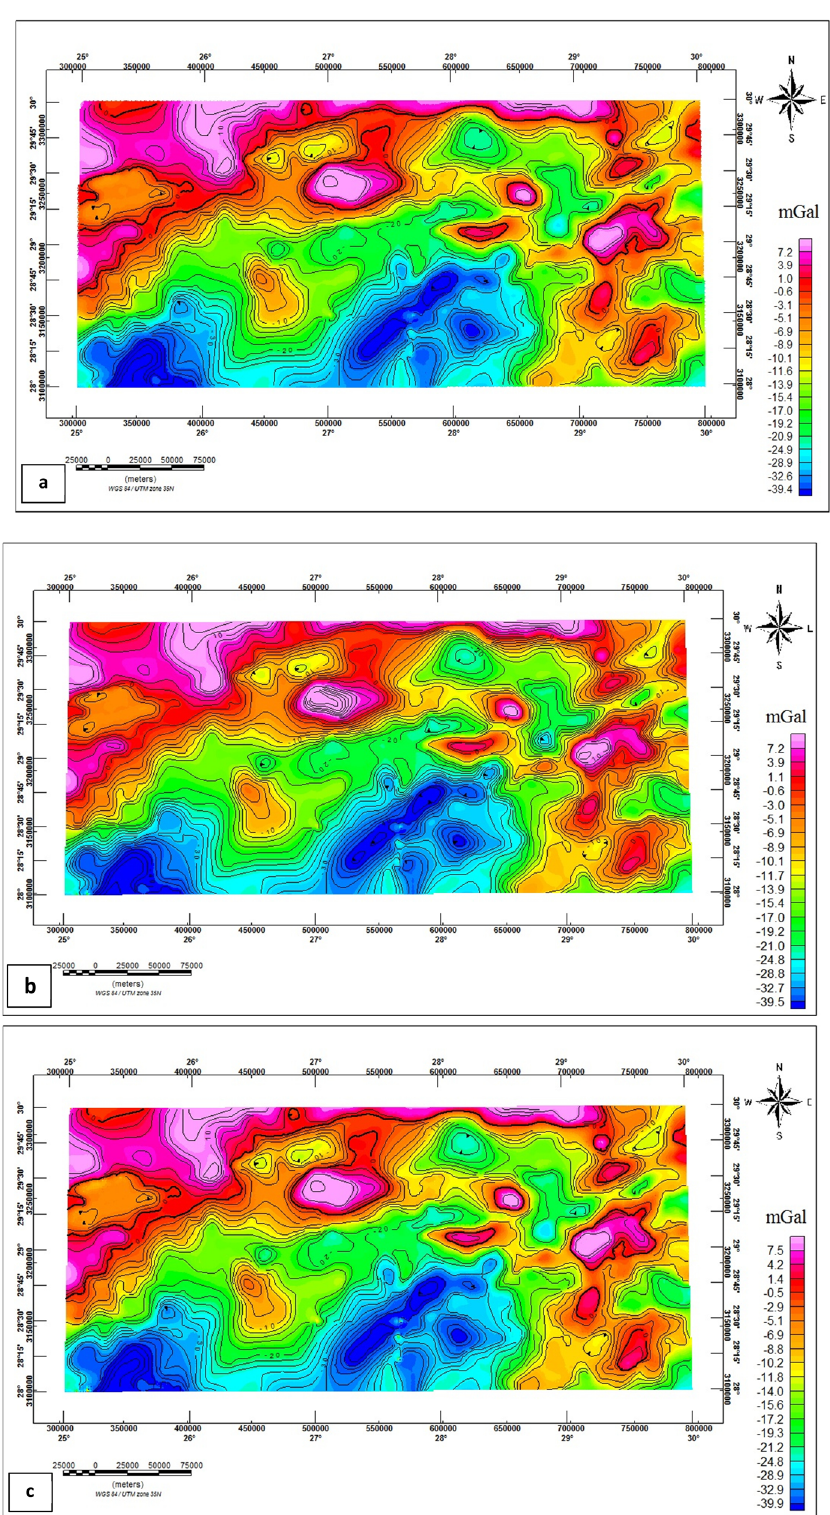
Figure 7: Downward continuation of Bouguer gravity anomaly maps at depths ( a ) 250, ( b ) 500, and ( c ) 1,000